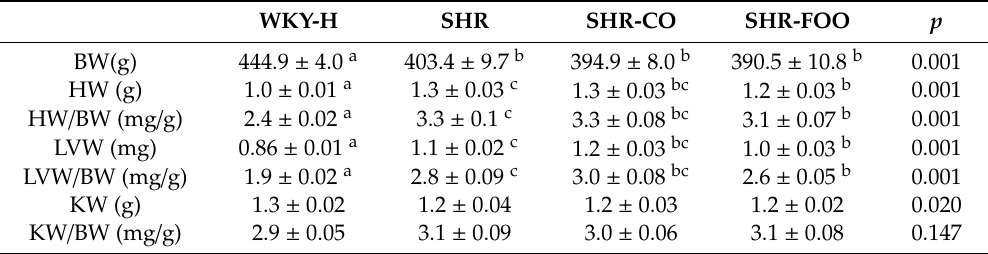
Table 2. Morphological variables in the experimental groups at the end of the experimental time.